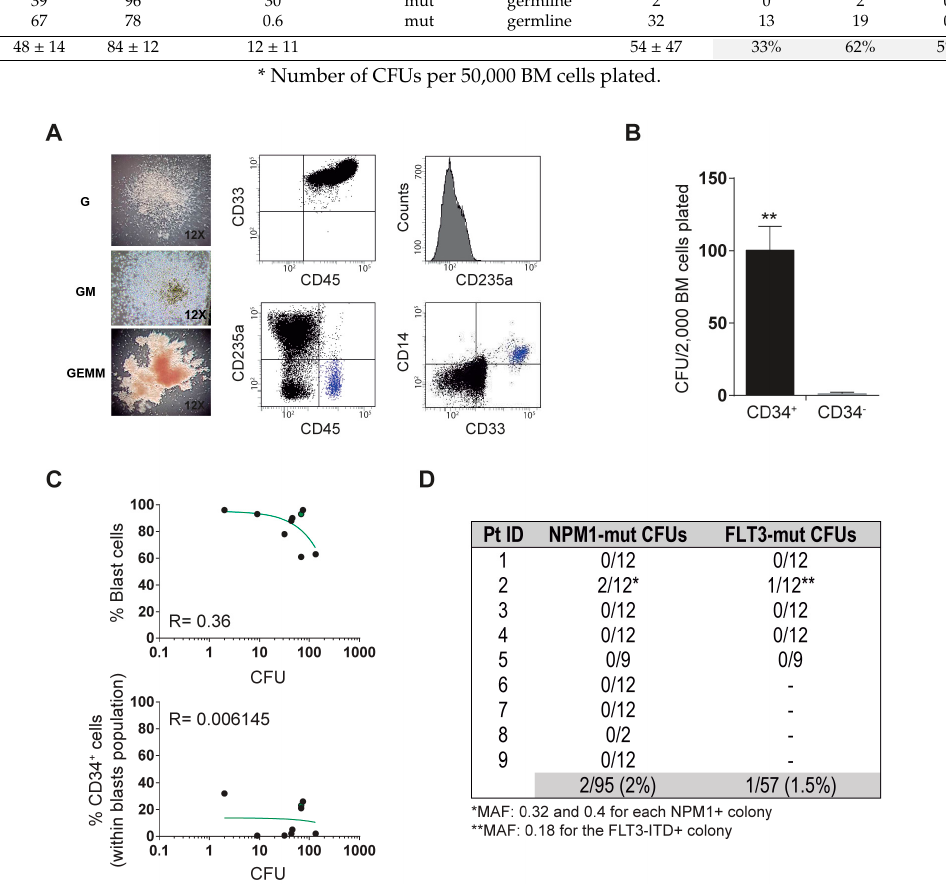
Figure 1. Characterization of clonogenic myeloid progenitors from bone marrow (BM) of NPM1-mutated acute myeloid leukemia (AML) patients. ( A ) Left, representative morphology of the indicated colony forming units (CFUs). HSC005 methylcellulose from VITRO SA (Madrid, Spain) was used. Right, representative immunophenotype of the indicated CFUs. ( B ) The CFU potential of BM cells from NPM1-mutated AML is exclusively confined to the CD34-enriched population. 2000 FACS-sorted CD34+ or CD34 − cells were plated in duplicate. ( C ) Correlation between the number of CFU and both the % of blasts (top panel) or the % of CD34+ cells (bottom panel). 50,000 total BM mononuclear cells were plated in triplicate. ( D ) Summary of the targeted-sequencing of NPM1 and FLT3 in individually plucked CFUs from BM of n = 9 NPM1 -mutated AML patients. Table 1. Clonogenic capacity of BM cells from NPM1 -mutated AML patients.